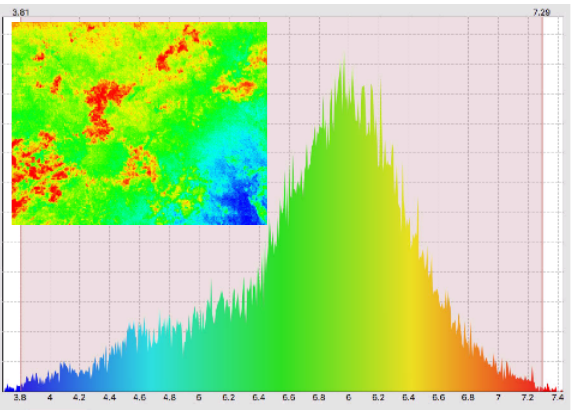
Figure 11: Histogram of image with complete forest coverage at test site "Pfynwald" temperature range: (3.8-7.4 °C), blue-red: